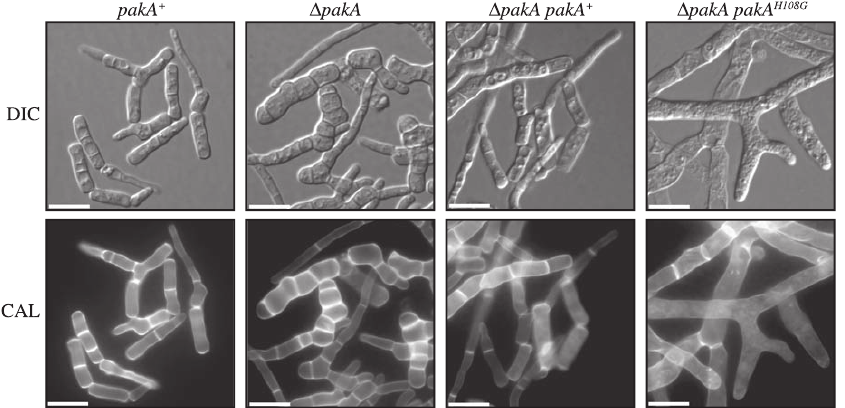
Figure 4. pakA Strains Show Aberrant Yeast Morphogenesis at 37 8 C The wild-type ( pakA þ ), D pakA , D pakA pakA þ , and D pakA pakA H108G strains were grown in liquid BHI medium at 37 8 C for 6 d. Wild type ( pakA þ ) produces arthroconidiating hyphae and a mixture of fragmented and separated yeast cells. The D pakA pakA þ strains are indistinguishable from wild type. The D pakA mutant produces swollen arthroconidiating hyphae with increased septation. Fewer yeast cells, which are also swollen and highly septate, are produced in the D pakA mutant. The D pakA pakA H108G strains produce swollen arthroconidiating hyphae that have reduced septation, and there are reduced numbers of yeast cells. Images were captured using DIC or with epifluorescence to observe calcofluor stained cell walls (CAL). Scale bars, 20 l m.